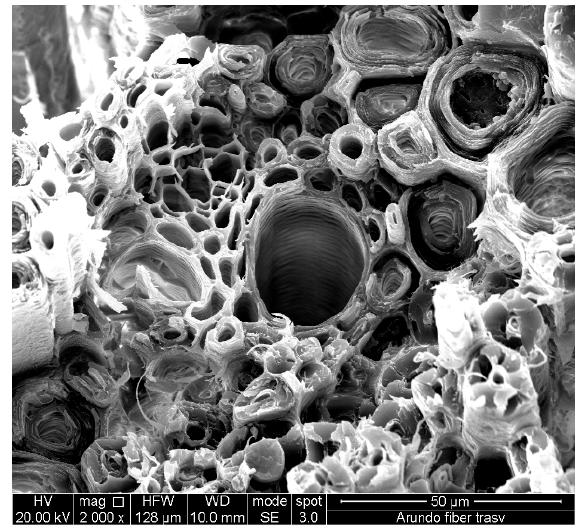
Figure 1. SEM micrograph of cross section of Arundo fiber.